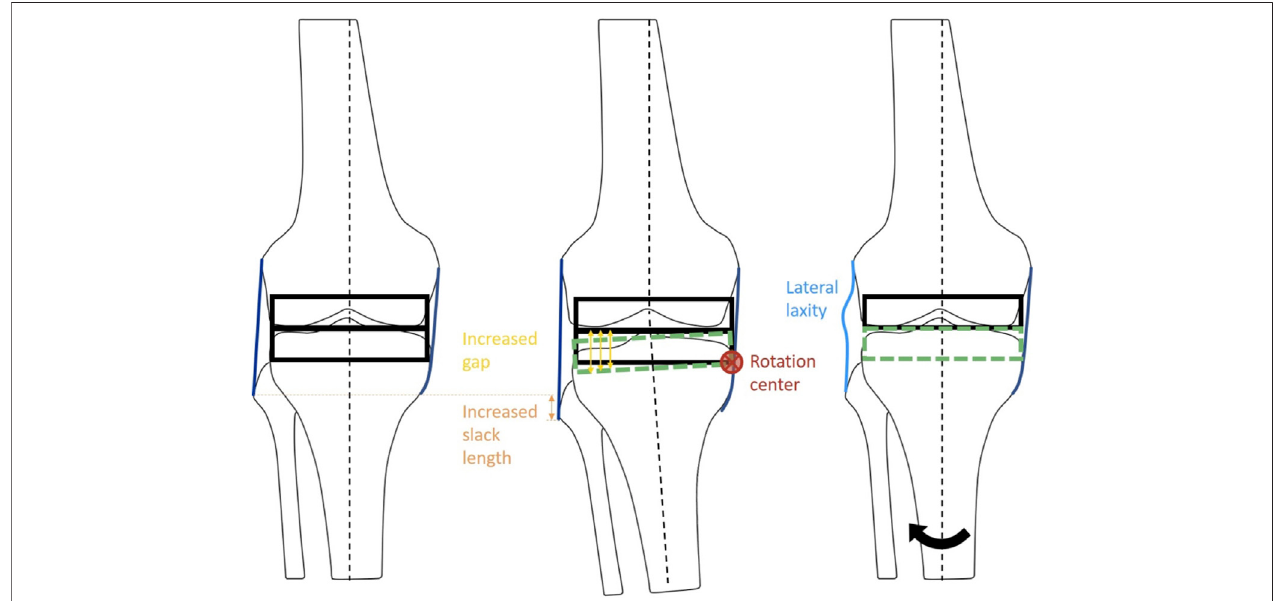
FIGURE 2 | Schematic diagram of the ligament adjustment process. The balanced neutral alignment model (left). Ligament adjustment performed at 2 ° varus (center). Model G: Neutral alignment model with laxity at lateral ligaments with balanced medial ligaments (right). Black arrow indicates the rotation of tibia from varus to neutral